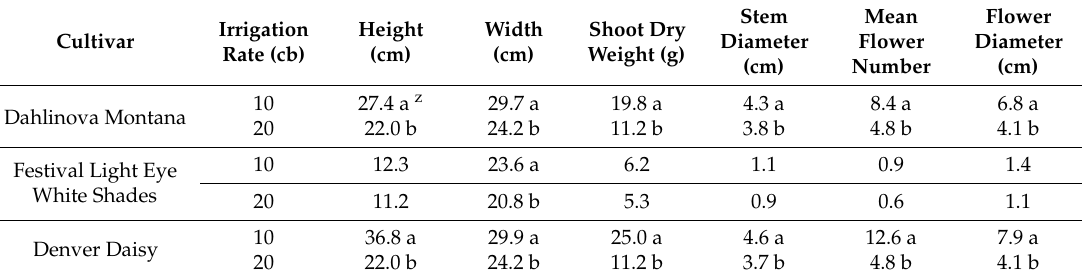
Table 3. Growth and flowering characteristics affected by irrigation, controlled by a tensiometer, averaged across diatomaceous earth treatments in Dahlia × hybrida ‘Dahlinova Montana’, Gerbera jamesonii ‘Festival Light Eye White Shades’, and Rudbeckia hirta ‘Denver